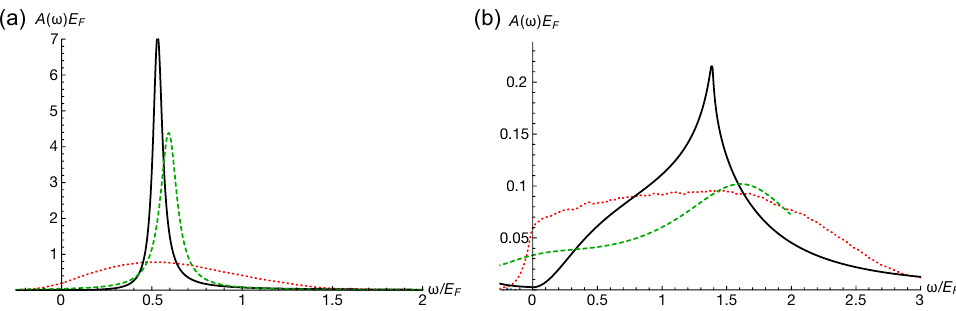
Figure 8. Spectral function A ( ω ) ≡ A ( 0 , ω ) of the Fermi polaron for m = m med and T = 0, calculated using a T -matrix formalism [77] (black, solid), functional renormalization group [83] (green, dashed), and diagrammatic Monte Carlo [51] (red, dotted), where in the latter case, we display the maximally smooth solution [51]. We show the results for slightly different values of 1/ k F a ≈ 1 ( a ), and for 1/ k F a = 0 ( b